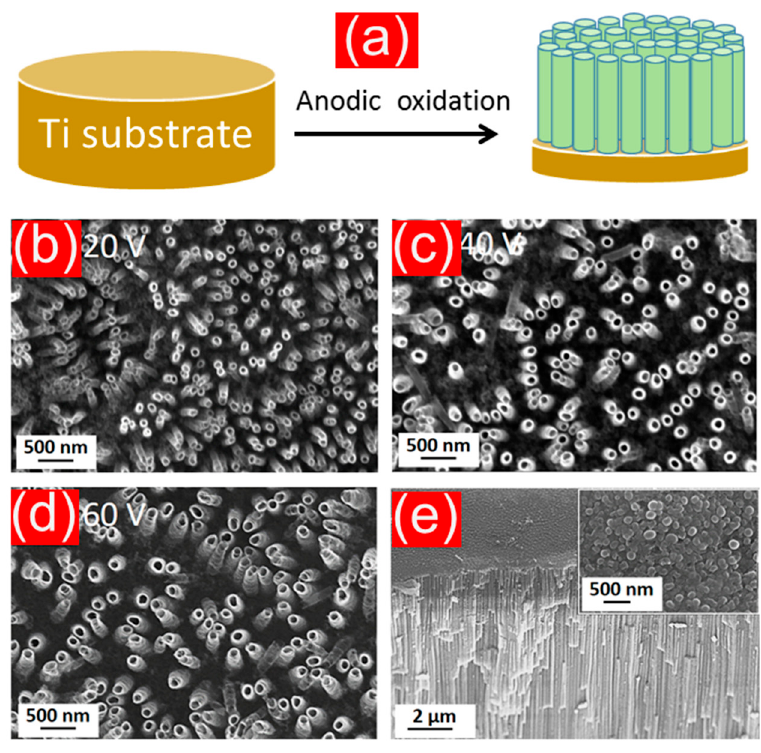
Figure 8. ( a ) Schematic illustration of the formation of TiO 2 nanotubes by the anodization of a Ti substrate. SEM micrograph of anodized Ti substrates in formamide-based electrolyte containing 0.2 M NH 4 F at different anodization voltage ( b ) 20 V, ( c ) 40 V, and ( d ) 60 V. ( e ) The cross-sectional view while the inset shows the bottom view of the nanotubes prepared at 60 V reprinted with permission from ref. [125].